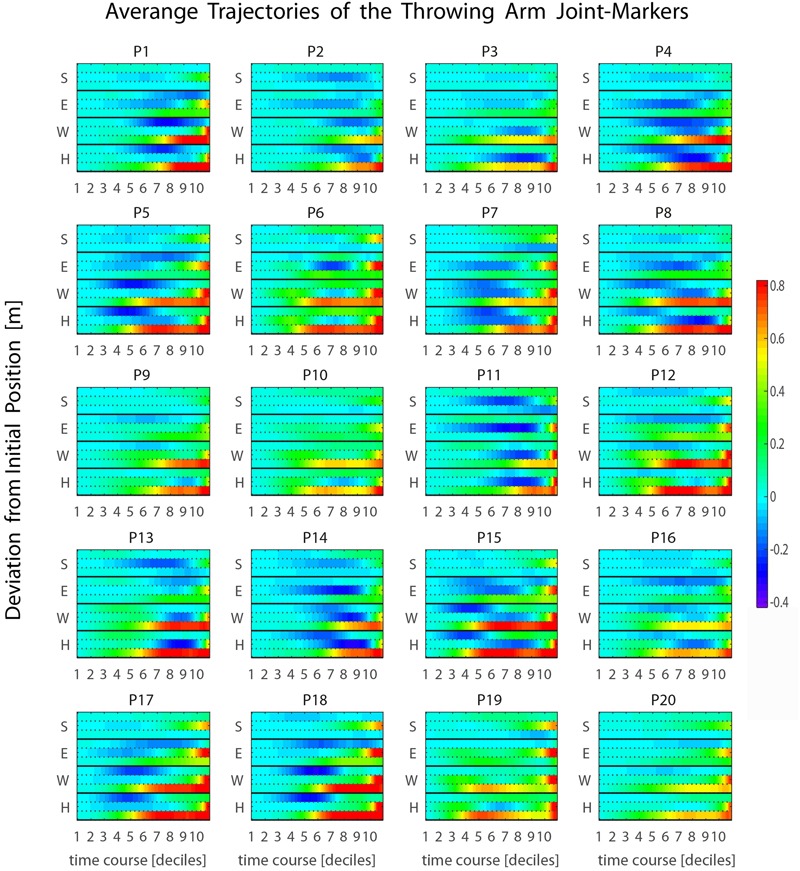
Average kinematics of the four throwing arm marker-joints. (S, shoulder; E, elbow; W, wrist; H, hand) for the 20 participants recruited in the study. The heat maps represent the temporal evolution of the deviation from the initial position through time. The three rows associated with each joint-marker represent the values for the three spatial coordinates, [x,y,z] from top to bottom respectively. For all participants the forward-projection phase occurs typically across the 9th and 10th deciles, i.e., about 200–100 ms before ball release.